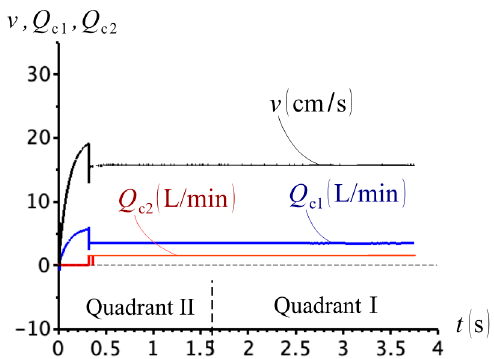
Figure 6. Cylinder velocity and check valve flows for load mass m = 0.5 kg .